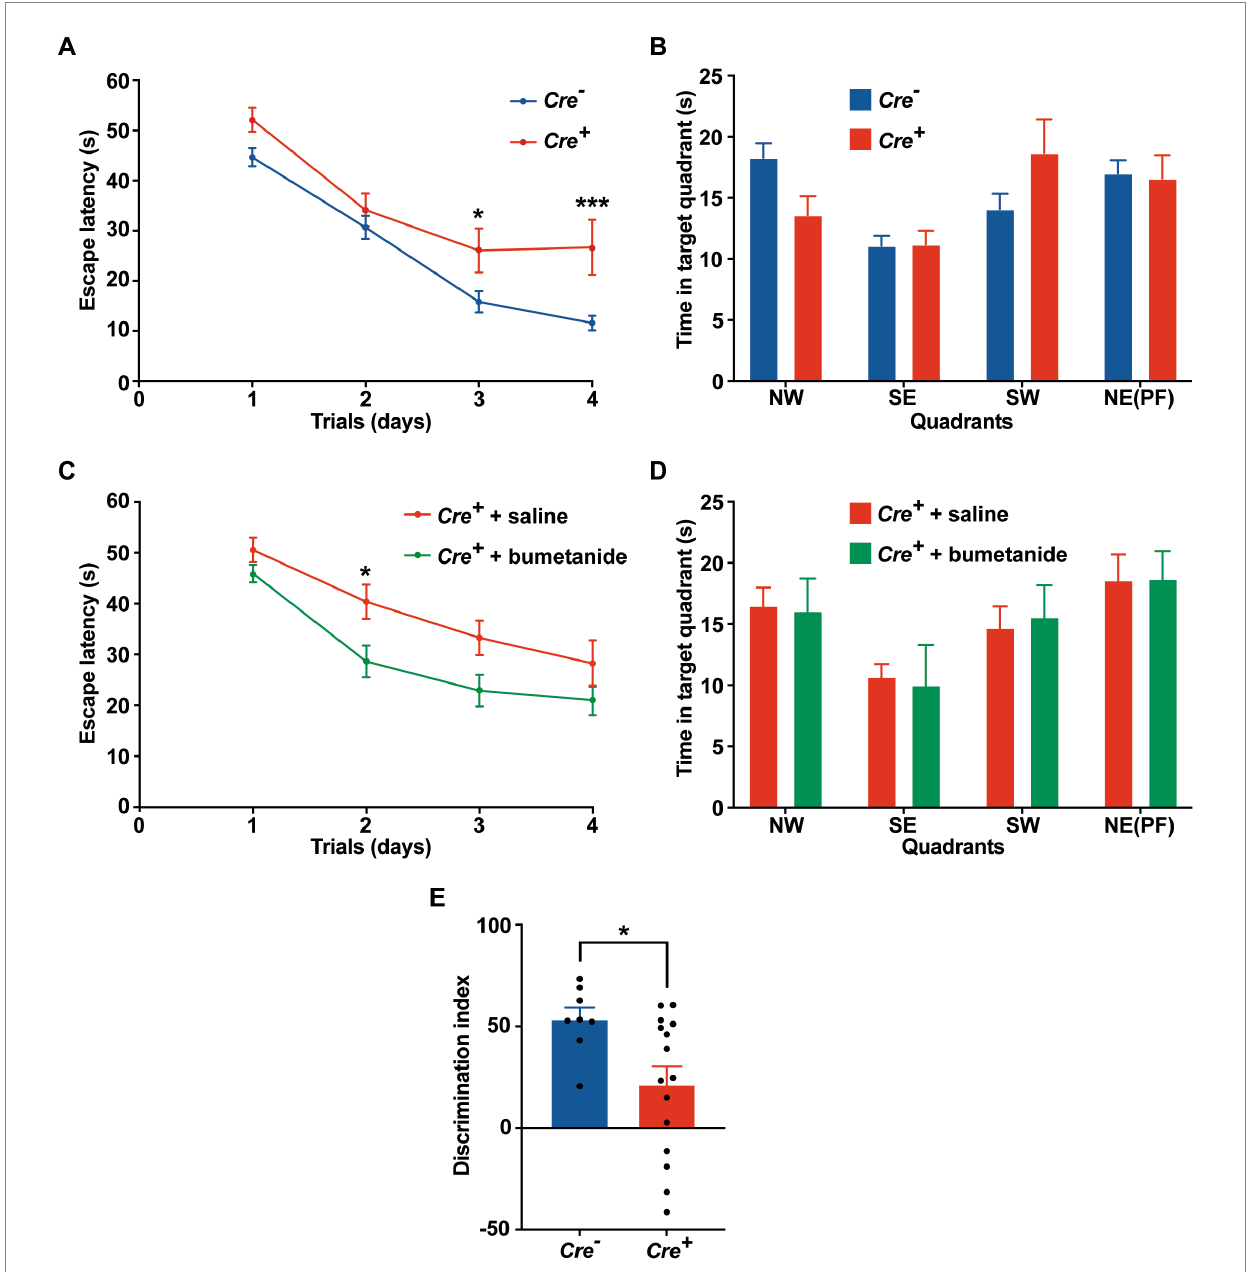
FIGURE 2 Behavioral evaluation of memory in Cre + and Cre-male mice at 3 months of age. (A-D) Morris water maze. (A) Escape latency in the MWM compared between Cre + ( n = 18) and Cre − ( n = 34) mice. (B) Probe test: time spent in each quadrant (PF: platform). (C) Improvement of escape latency in the MWM after injection of Cre + mice with saline ( n = 17) or bumetanide ( n = 22). (D) Probe test: time spent in each quadrant (PF: platform). Values are means ± SEM; * p -value ≤ 0.05; *** p -value ≤ 0.001; two-way ANOVA with Sidak’s post-hoc test). (E) Novel object recognition. Discrimination index in the NOR task ( n = 8 for Cre − , n = 16 for Cre + mice; unpaired t